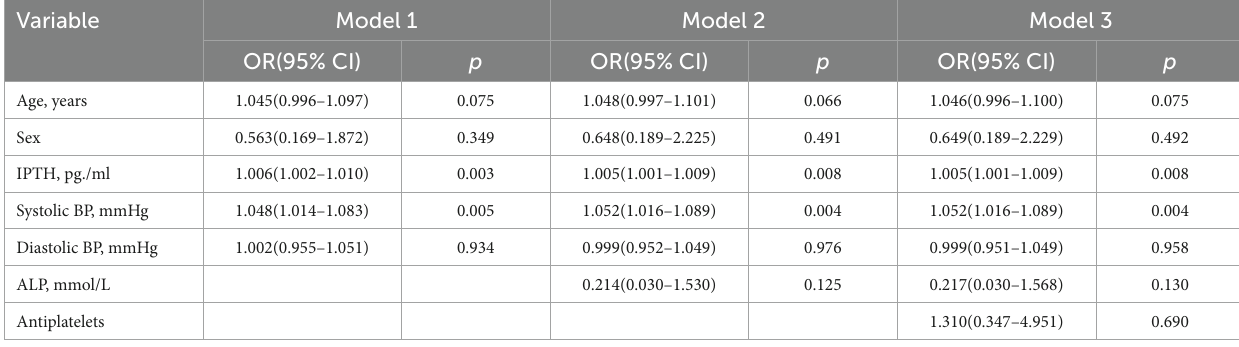
TABLE 2 Multivariate logistic regression for independent variables potentially related to the incidence of ICH.